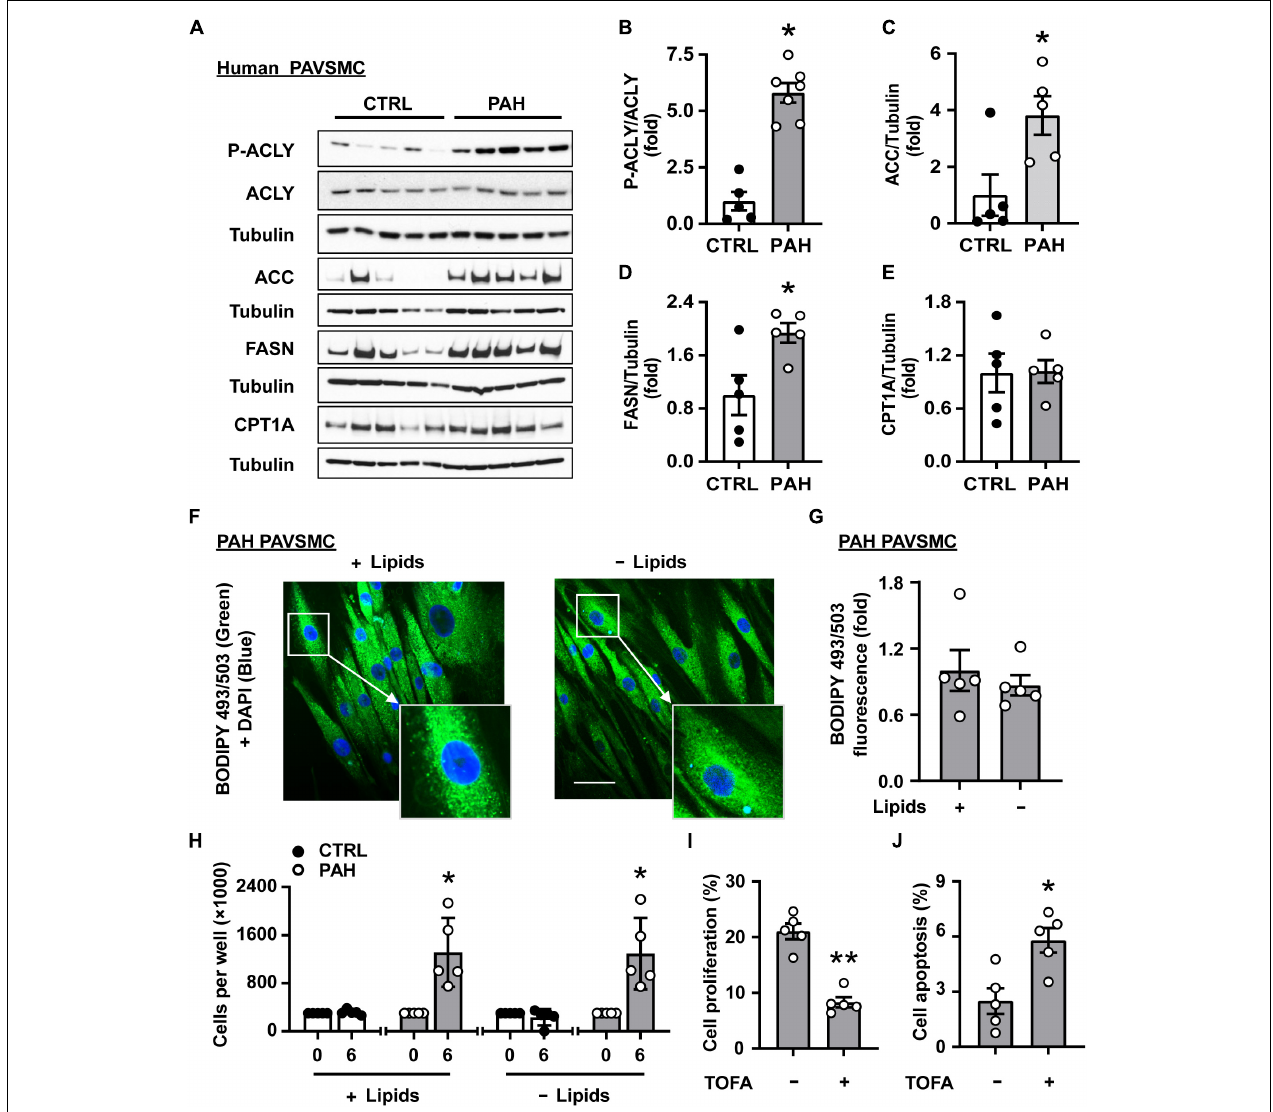
FIGURE 1 | Increased lipid synthesis is required for hyper-proliferation and survival of human PAH PAVSMC. (A–E) Early passage distal primary human PAVSMC from non-diseased (CTRL) and PAH subjects were serum-deprived for 48 hours and subjected to immunoblot analysis to detect indicated proteins. n = 5 (CTRL), n = 7 (PAH for P-ACLY, ACLY, see Supplementary Figure 1A for additional immunoblots used for statistical analysis) or n = 5 (PAH for ACC, FASN, CPT1A). Data are means ± SE, fold to control. (F,G) Human PAH PAVSMC were incubated for 48 h in serum deprived media supplemented with regular (+ Lipids) or lipid-deprived (-Lipids) 0.1% BSA and subjected to fluorescent BODIPY 493/503 staining (green) to detect intracellular neutral lipids followed by DAPI (blue) staining to detect nuclei. Representative images with enlarged area (F) and statistical analysis (G) are shown. Bar equals 50 µ m. Data are means ± SE from n = 5 subjects/group, fold to cells incubated in regular 0.1% BSA (+ Lipids) group. (H) Equal amount of human PAVSMC from five PAH and five control subjects were seeded to 6 well plates. 48 h later (day 0), media was changed to the serum-free media supplemented with regular (+ Lipids) or lipid-deprived (-Lipids) 0.1% BSA; six days later, cell count assay was performed. Data are means ± SE, n = 5 subjects/group. (I) PAH PAVSMC were treated with ACC inhibitor TOFA (20 µ M) for 48 h followed by proliferation analysis (Ki-67). Data are means ± SE, percentage of Ki-67 positive cells/total number of cells, n = 5 subjects/group. (J) PAH PAVSMC were treated with ACC inhibitor TOFA (20 µ M) for 48 h followed by apoptosis analysis. Data are means ± SE, percentage of TUNEL-positive cells/total number of cells, n = 5 subjects/group. * p < 0.05, ** p < 0.01 by Mann–Whitney U test.